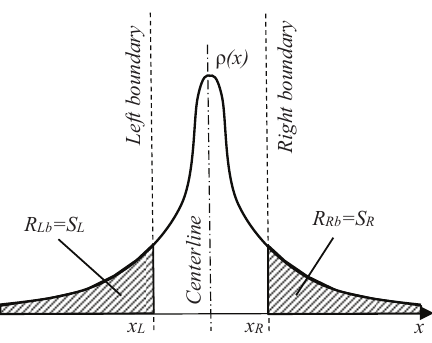
Figure 2. Risk of airplane deviation out of predefined